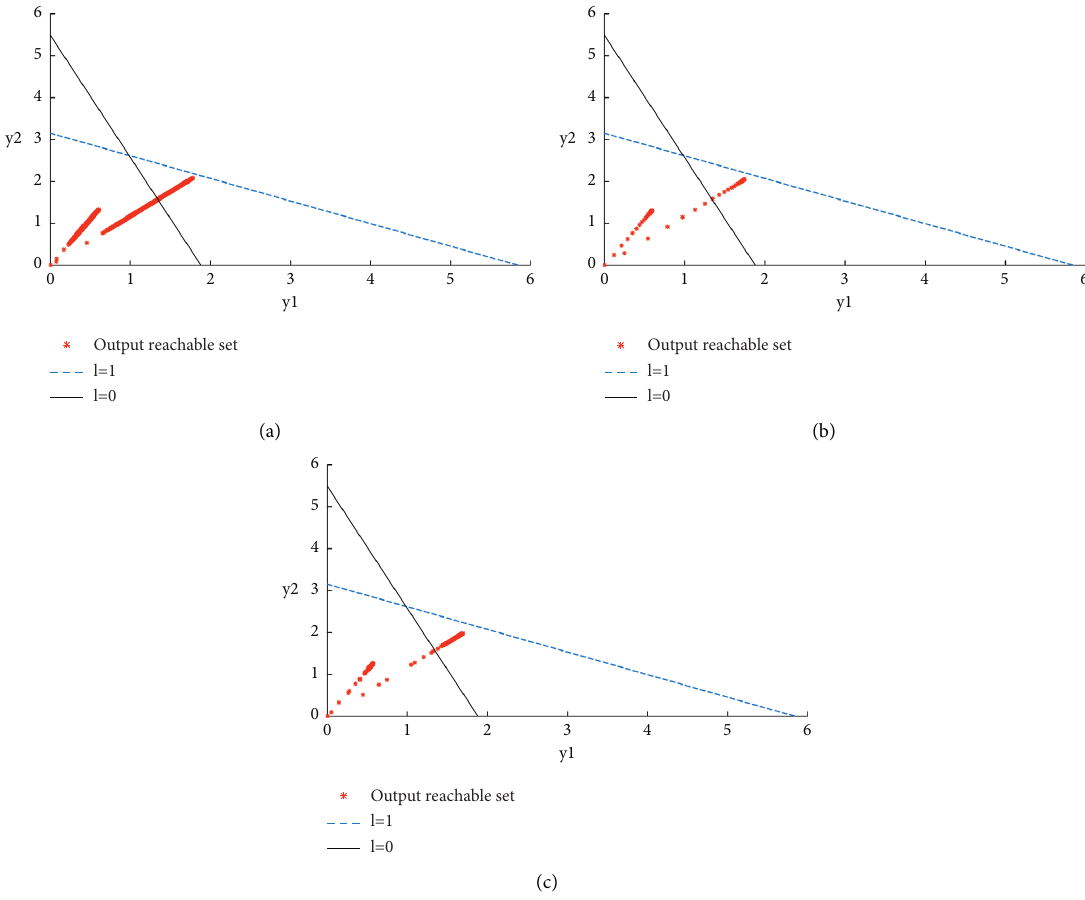
Figure 2: Estimation of the output reachable set with ϑ ∈ Σ +